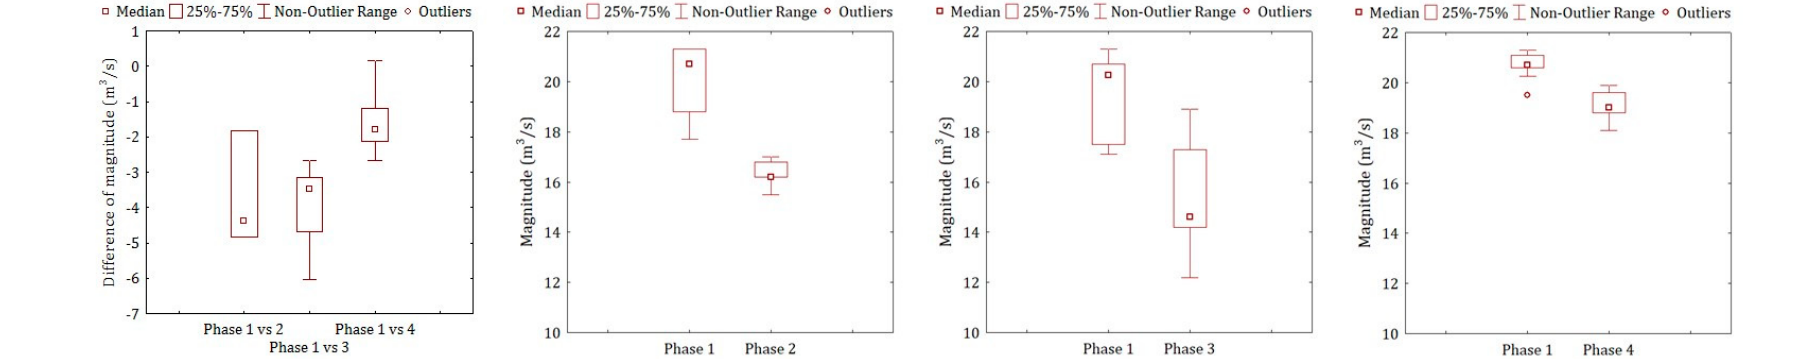
Figure 7. The comparison of the magnitude of low flows in different phases during the forest harvesting period.